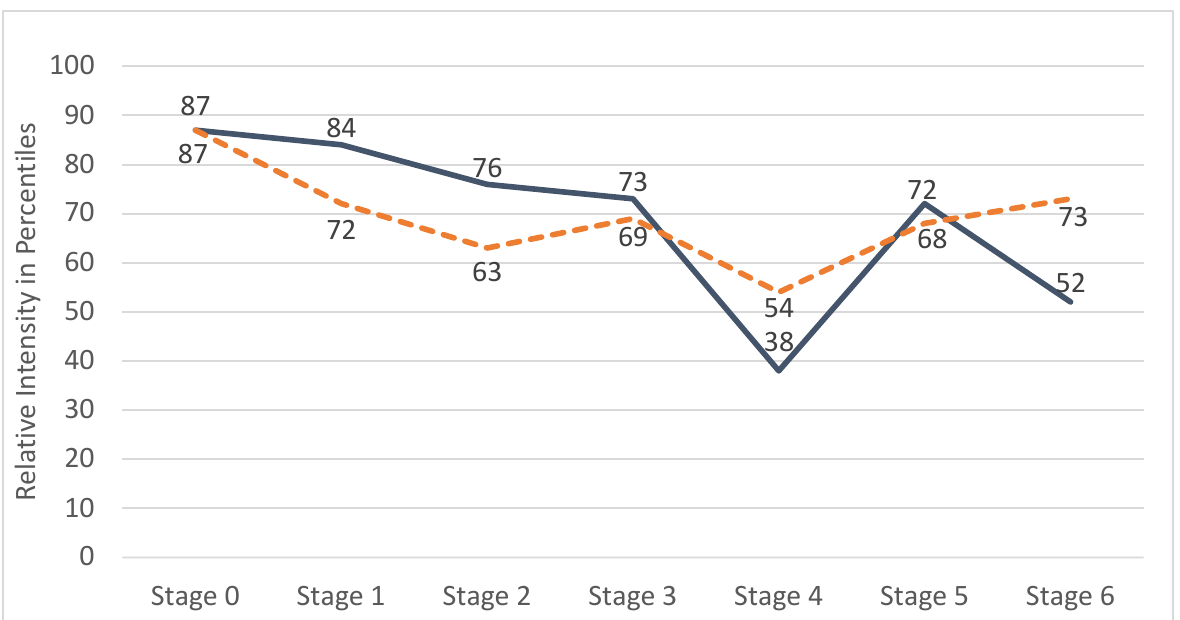
Before and After SOCQ Profiles for the